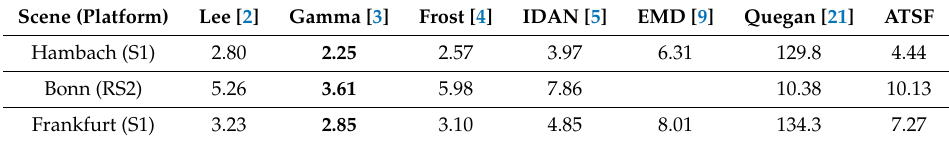
Table 2. Comparison of mean spectral angle differences in degrees, best results in